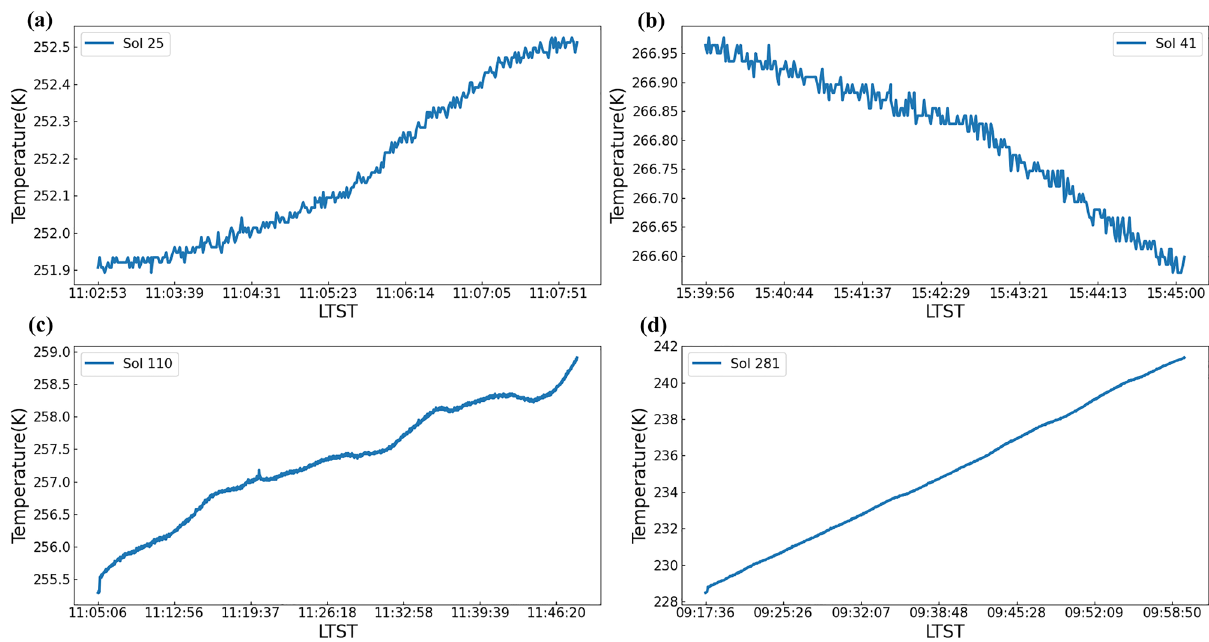
Figure 6. Temperatures recorded in different sols. Due to the limitations of flight control conditions and multiple-sensor coordination, temperature measurement information is not available every day. Each line in the figure represents the change in temperature during one sol. It can be seen from the subfigures that the temperature is recorded in less than 1 h, more exactly, about 5 min during the traditional mode and about 40 min during the maneuver mode. ( a , b ) are MCS working in traditional mode. ( c , d ) are MCS working in maneuvering mode.